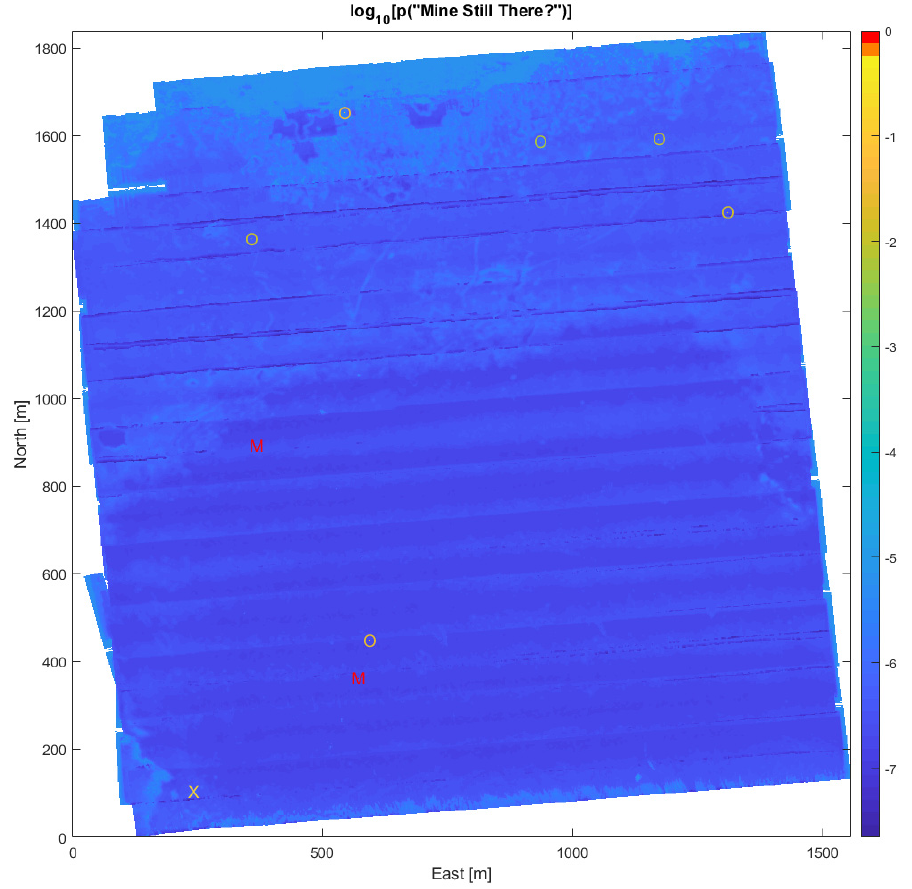
Figure 7. The mine probability surface (on a logarithmic scale) obtained by considering all the information in each cell. Symbols represent: identified mines (M), NOMBOs (O), and unidentified MILCOs (X). These symbols are also coloured by the logarithm of mine probability.